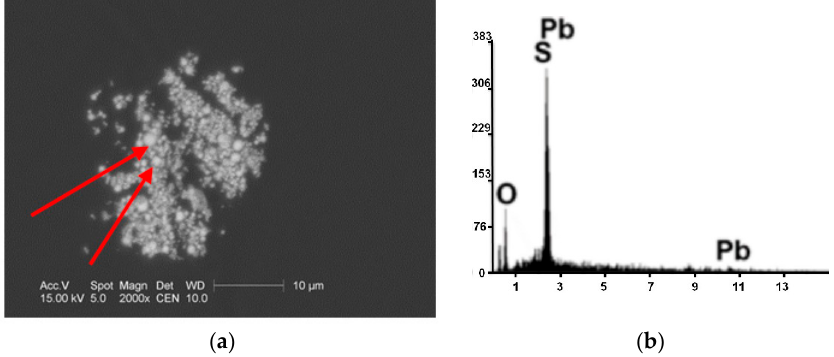
Figure 11. Dust particles from the lead refinery process (sample No. 11): ( a ) SEM images; the red arrows indicate lead sulphate: anglesite PbSO 4 and lanarkite; ( b ) the EDS spectrum.